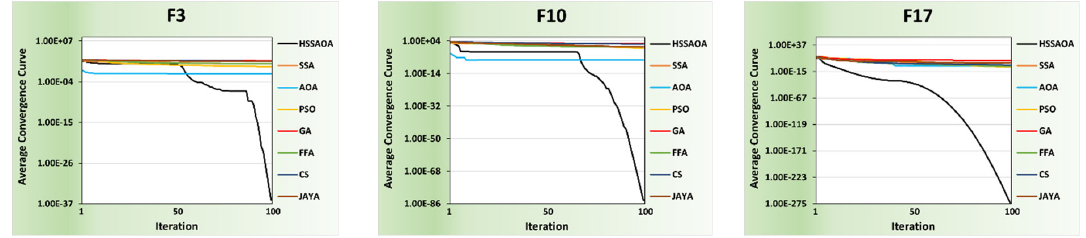
Fig. 5 Logarithmic convergence curve of some functions according to Group